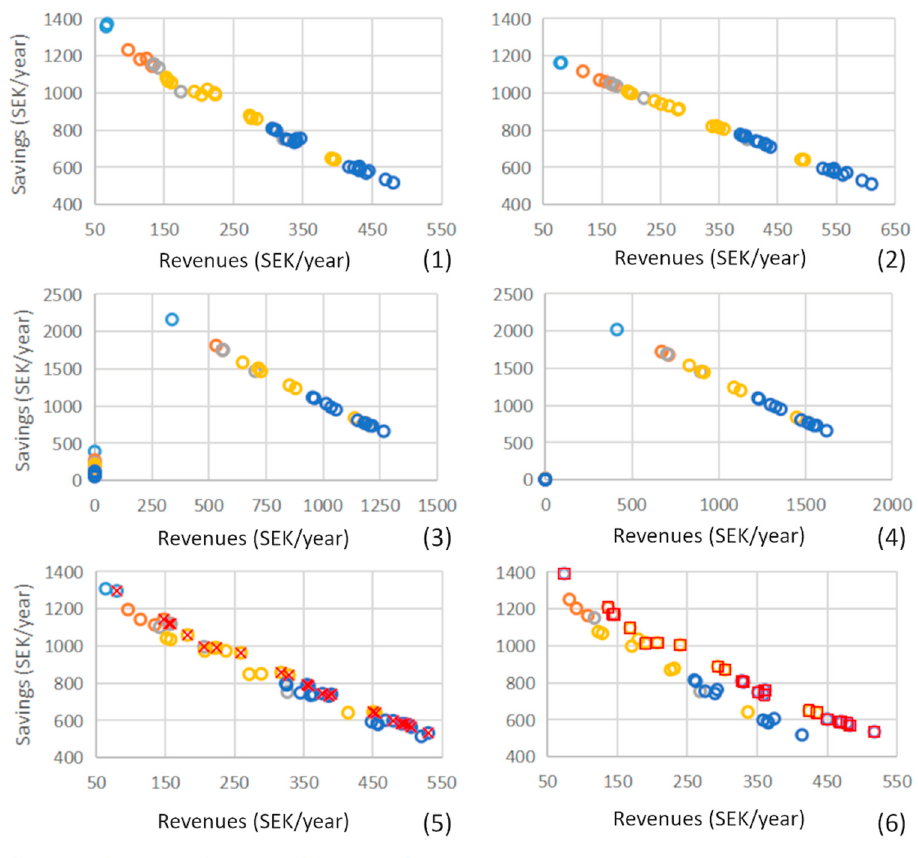
Figure 7. Savings V.S. revenues for each household in the microgrid. Both axes are in SEK/year ( 1 ) Scenario 1 ( 2 ) Scenario 2 ( 3 ) Scenario 3 ( 4 ) Scenario 4 ( 5 ) Scenario 5 ( 6 ) Scenario